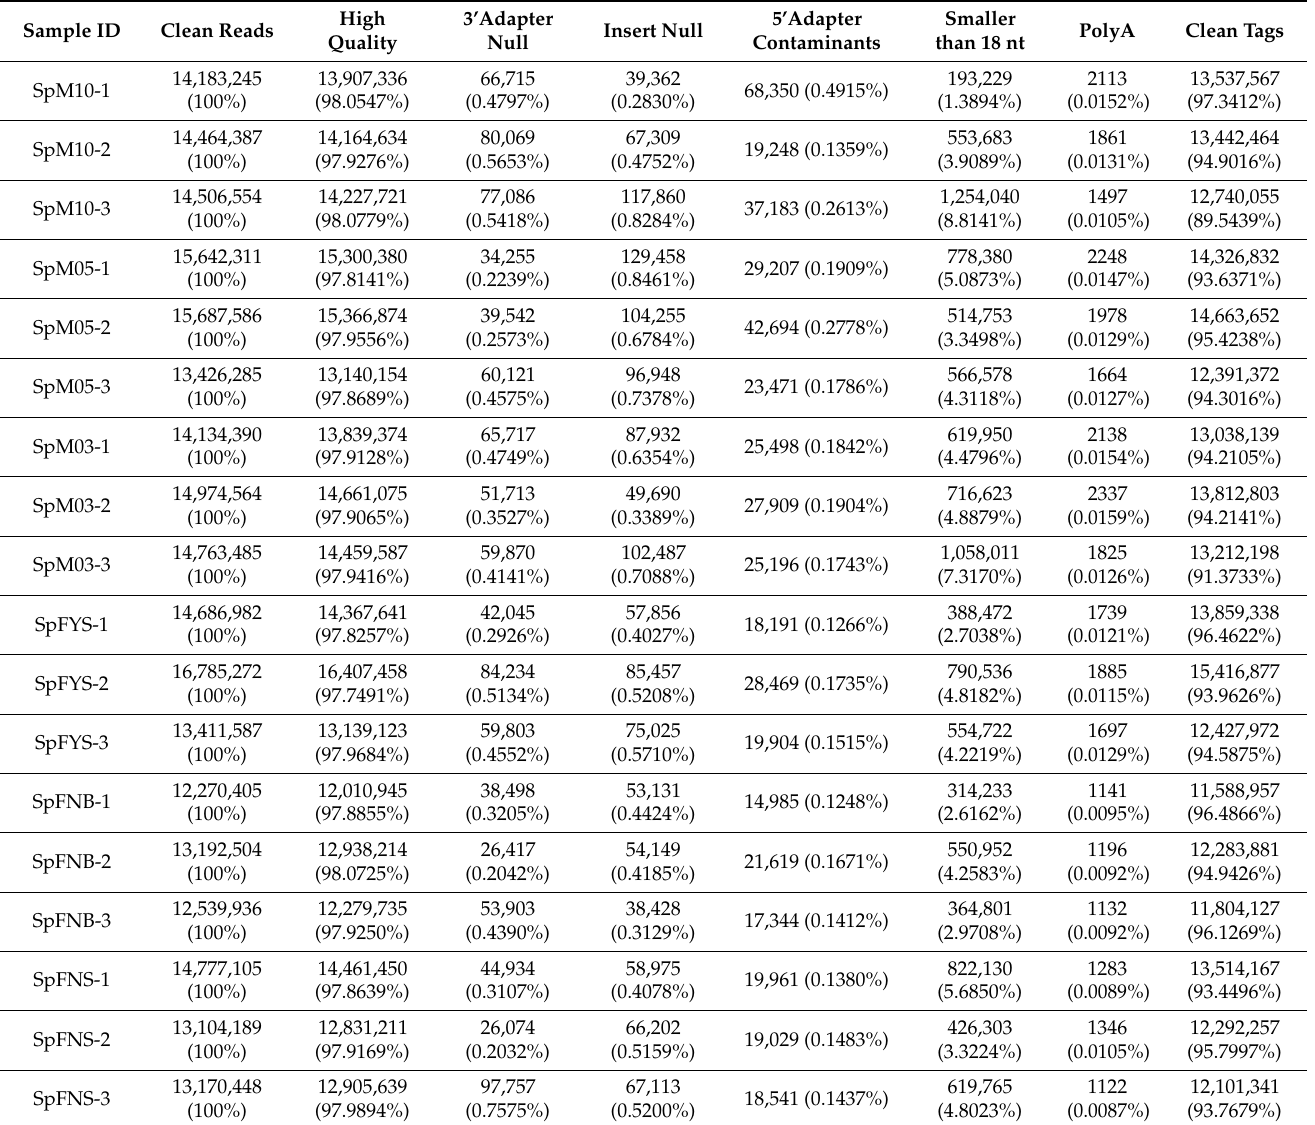
Table 1. Summary of small RNA